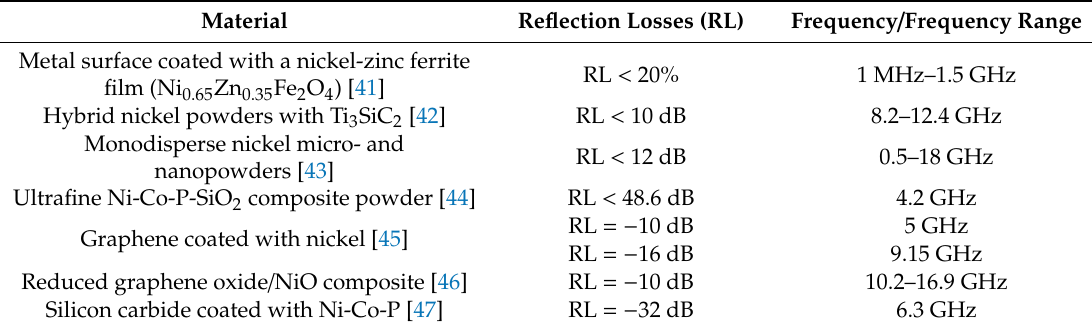
Table 4. Reflection losses of nickel powder-based